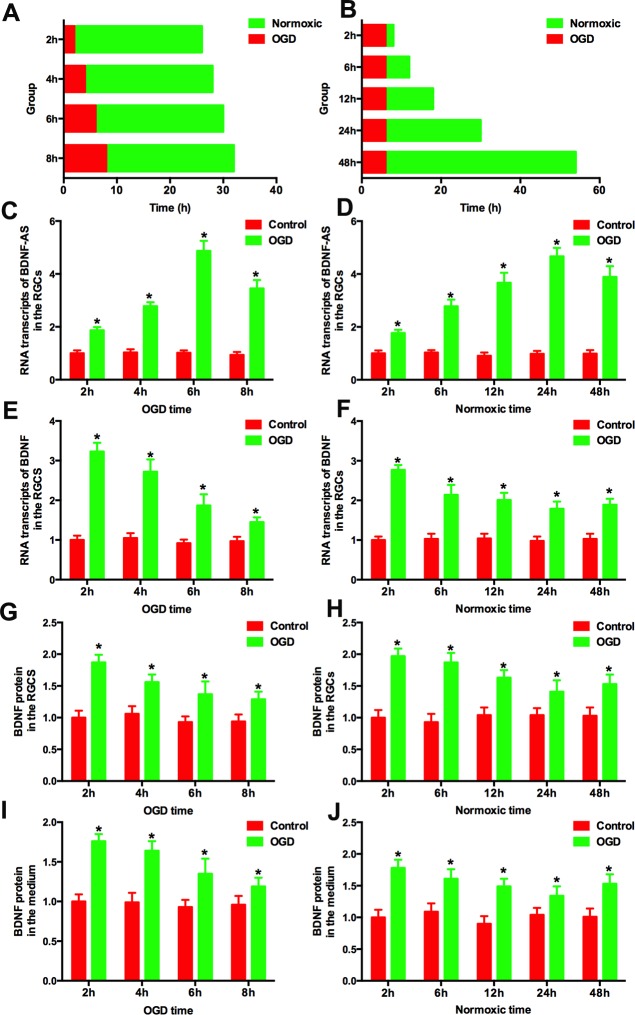
Elevation of BDNF-AS in ischemic RGCs.(A) RGCs were subjected to ischemia for different lengths of time following 24 h of normoxic culture. (B) RGCs were exposed to ischemia for6 h and harvested at different times. (C) BDNF-AS was increased in ischemic RGCs. The peak levels were achieved after 6 h of ischemia. (D) Elevation of BDNF-AS was observed at different time points after 6 h of ischemia. (E) BDNF mRNA was increased in the ischemic group while a trend was negatively correlated with BDNF-AS. (F) BDNF mRNA was inversely related with BDNF-AS at different time points after 6 h of ischemia. BDNF protein levels in the RGCs (G) and medium (I) were correlated with BDNF mRNA levels. After 6 h of ischemia, the RGCs (H) and their medium (J) were harvested at different time points, and BDNF protein levels maintained a similar trend with mRNA expression. P<0.05 was considered significantly different; * vs control group.